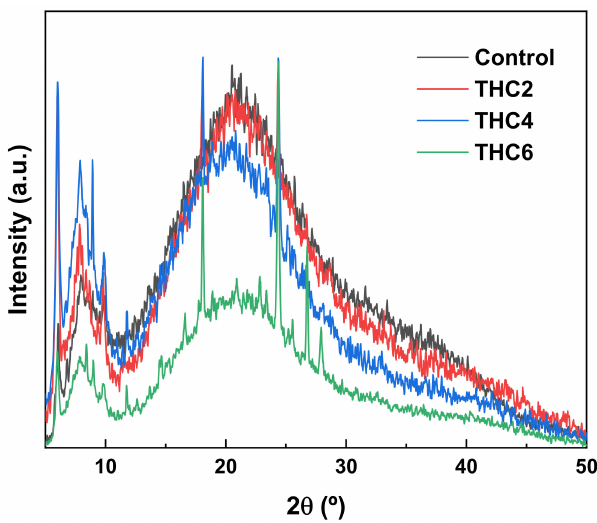
Figure 6. XRD patterns of collagen